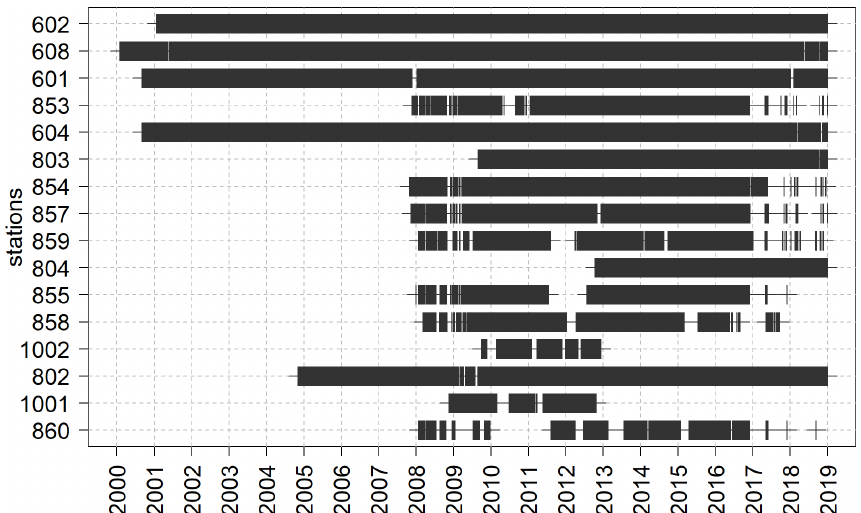
Figure 2. Data availability in the analyzed period (1 February 2000–31 December 2018) for each weather station. Stations are sorted by increasing altitude from the top to the bottom